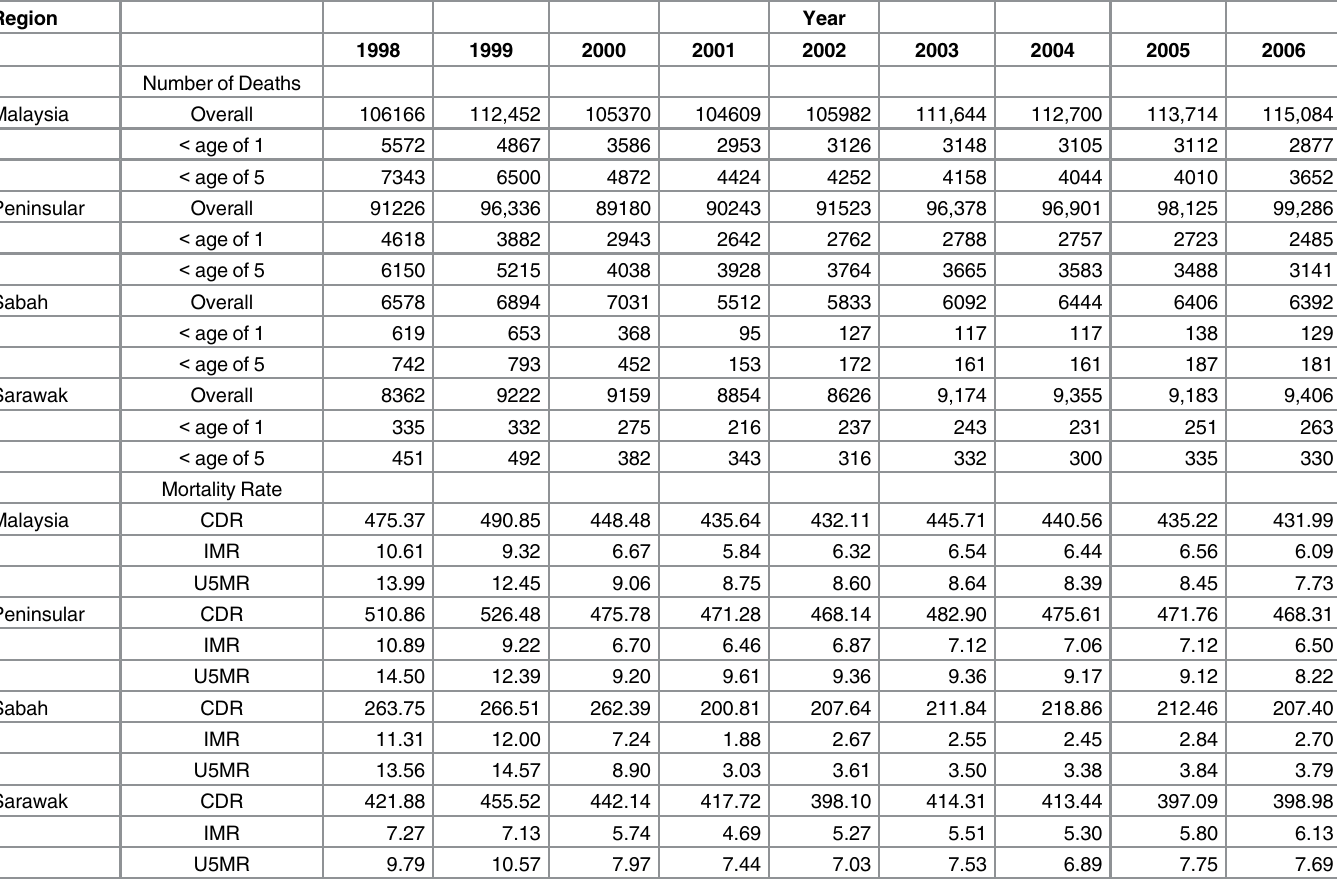
Table 1. Number of Deaths and Mortality Rates by Region, Malaysia 1998 to